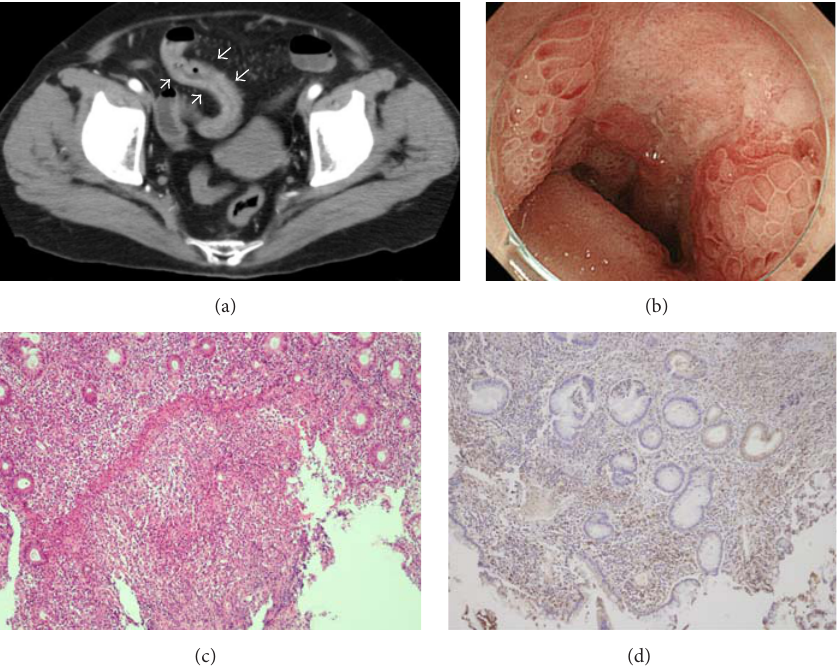
Figure 2: Intestinal findings. Abdominal CT scan showed localized thickening of the intestinal wall (arrows) (a). Endoscopic study revealed multiple ovoid punched-out ulcers at the terminal ileum (b). HE staining of a biopsy of the terminal ileum showed the presence of ulcer- associated granulation tissues with vascularization and infiltration of cells (original magnification × 100) (c), which were strongly positive for lysozyme (d) (original magnification × 100). Positive stains for CD13, CD14, and CD33 are not